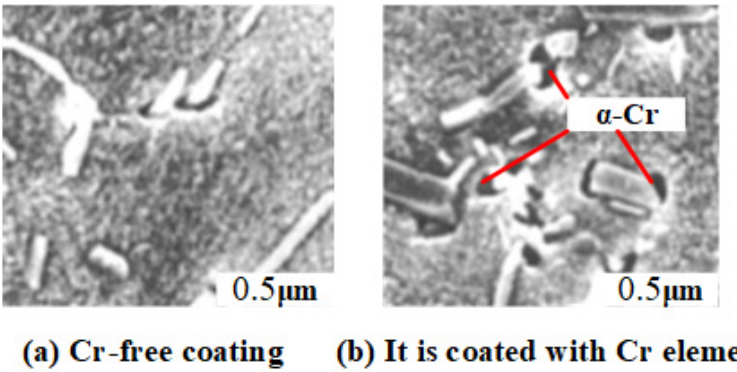
Figure 3. Metallographic diagram ( a ) with or ( b ) without Cr coating.